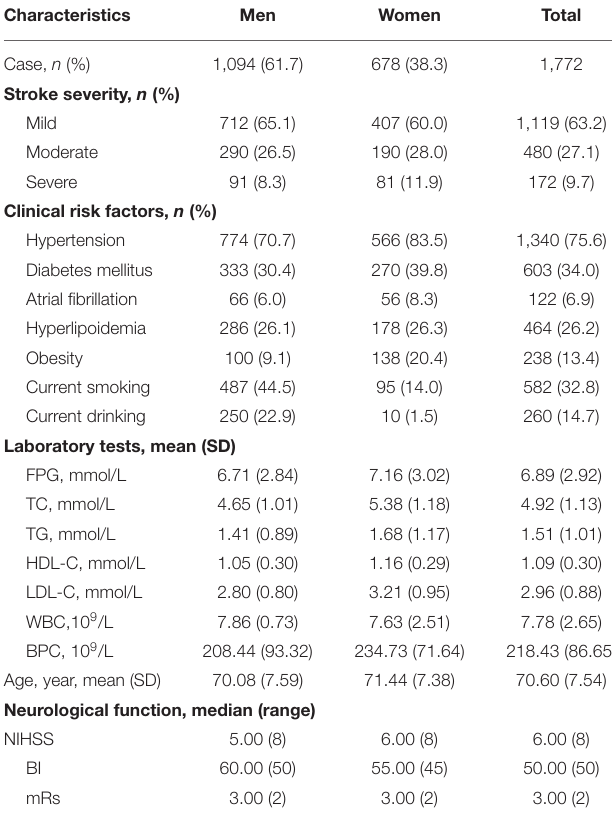
TABLE 1 | Baseline characteristics of patients with LAA stroke (age ≥ 60 years) stratified by sex group.